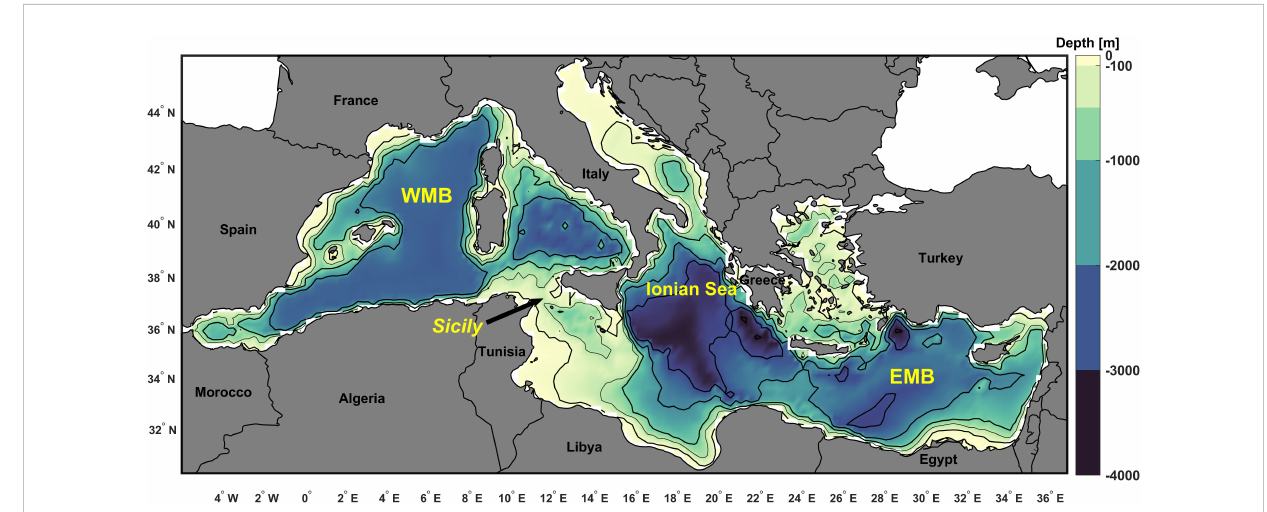
FIGURE 1 The Mediterranean Sea with the main geographic features (e.g., countries). The bathymetry is according to the GEBCO bathymetric dataset